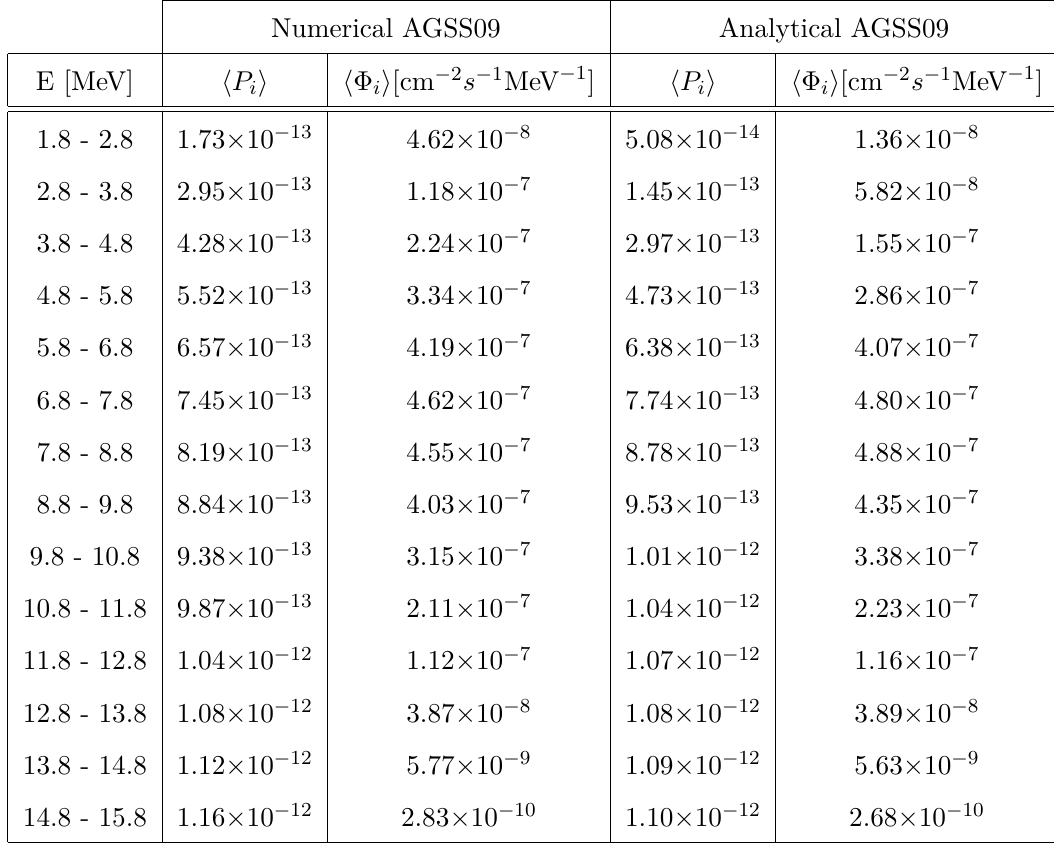
Table 1 . Averaged ¯ ν e appearance probabilities and expected fluxes of ¯ ν e from the Sun for low- metallicity AGSS09 SSM. Detection through inverse beta decay is assumed; magnetic field pro- file (2.42) and µ 12 B ⊥ ( r 0 ) = 10 − 12 µ B · kG were chosen. For rescaling to different values of µ 12 B ⊥ ( r 0 ) see